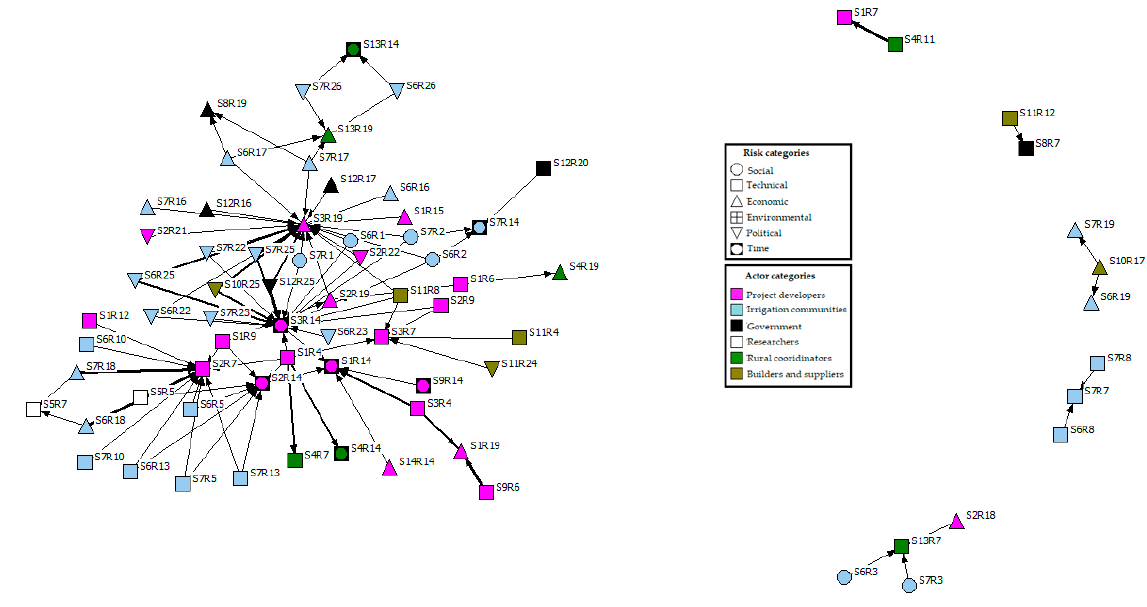
Figure 6. Structure of the network of risks associated with actors. In the central part of the network, the nodes with the most connections are located, such as S1R14, S2R7, S2R14, S3R7, S3R14, S3R19. These dependent nodes are involved in